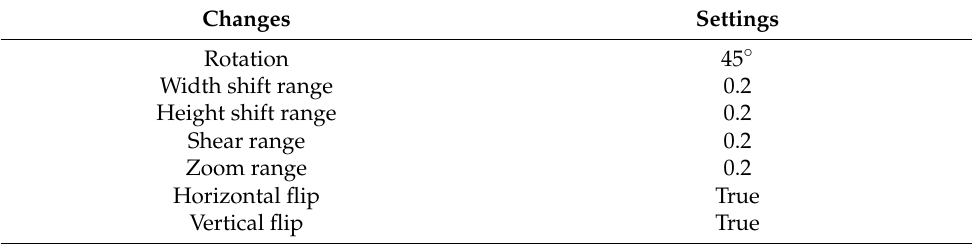
Figure 1. Various image augmentation methods for the same image ( a ). ( a ) Original image; ( b ) Rotated image; ( c ) Width shift range; ( d ) Height shift range; ( e ) Shear range; ( f ) Zoom range; ( g ) Horizontal Flip; ( h ) Vertical Flip. Table 4. Image augmentation approaches .